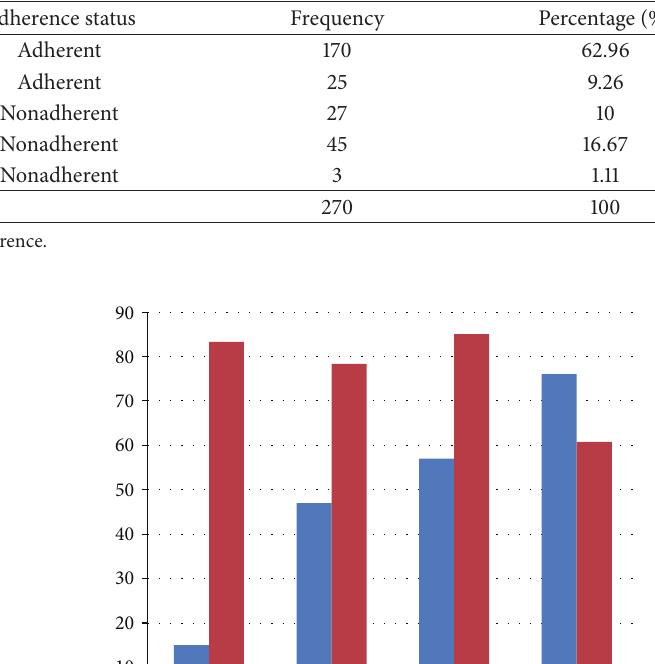
Table 4: Frequency distribution of adherers and nonadherers, Adama, Ethiopia, 2014.